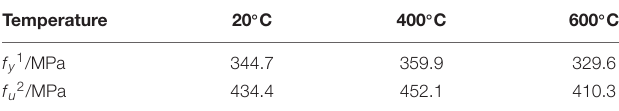
TABLE 3 | Mechanical properties of steel section.